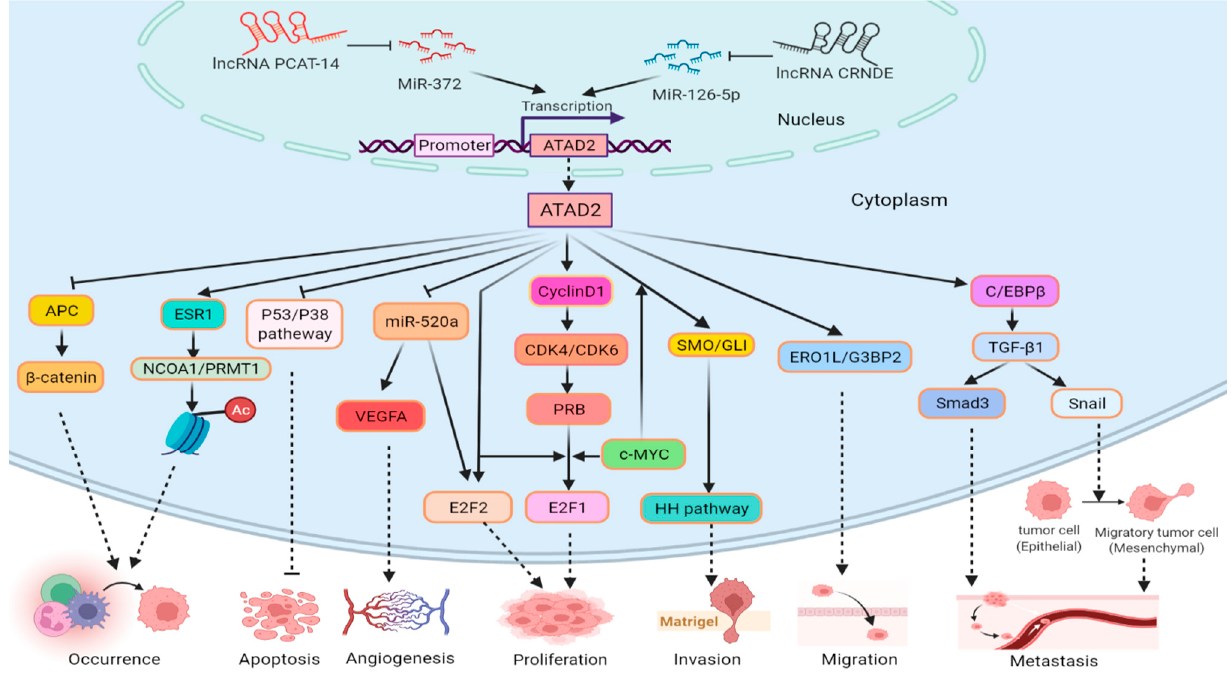
Figure 2. Role of ATAD2 in digestive system malignant tumors. lncRNA PCAT-14 and CRND inhibit, respectively, miR-372 and miR126-5p to promote the transcription of ATAD2 . ATAD2 promotes tumor cell proliferation, invasion, migration, and tumorigenesis through the pRb-E2F1 pathway, HH pathway, ERO1L/G3BP2, and APC/ β -catenin. ATAD2 increases the differential expression of NCOA1/PRMT1 via ESR1, which affects the acetylation level of histones to promote tumorigenesis. ATAD2 represses miR-520a and promotes the expression of VEGFA and E2F2, which are asso- ciated with tumor angiogenesis and tumor cell proliferation, separately. ATAD2 promotes the ex- pression of Snail and Smad3 via C/EBP β / TGF- β 1, Smad3 facilitates tumor metastasis, and Snail enhances it by EMT. ATAD2 also promotes proliferation and inhibits apoptosis, respectively, via the E2F2 and p53/p38 pathways in tumor cells.